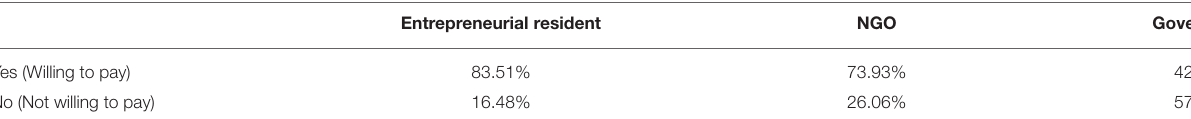
TABLE 1 | Kya Sands Settlement residents’ willingness to pay for green space development.